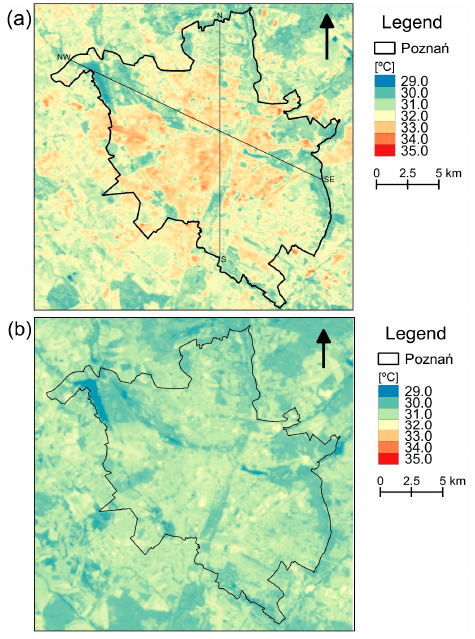
Figure 7. Air temperature in Pozna ń on 12 July 2010 ( a ) and 11 August 2015 ( b ) at 9:34. Profile lines ( a ) used in Figure 9.